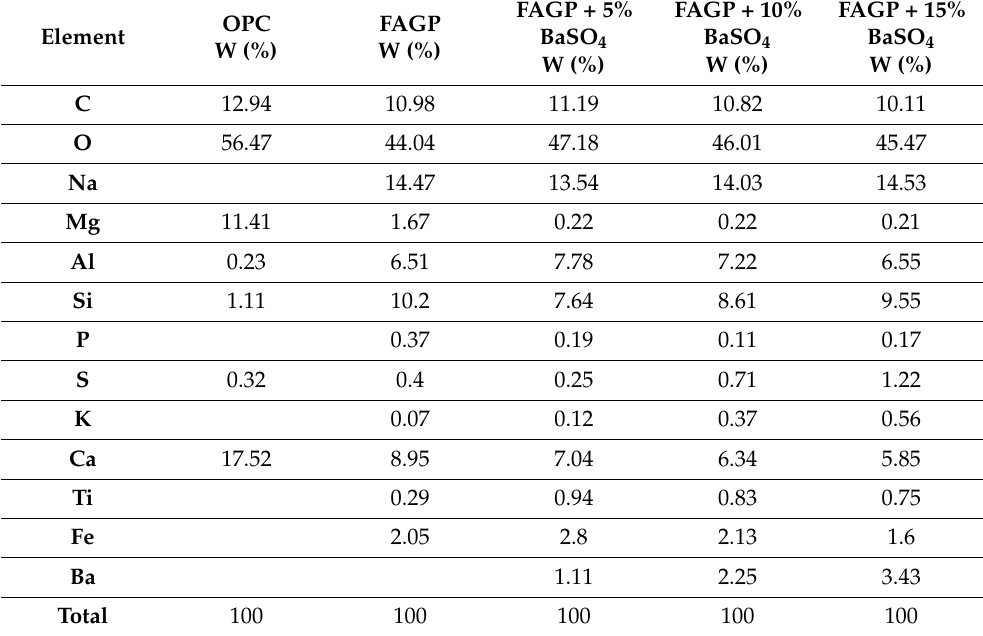
Table 1. Different elemental ratios in OPC, fly ash geopolymer material (FAGP) prepared without and with (5, 10, and 15 % of BaSO 4 ).